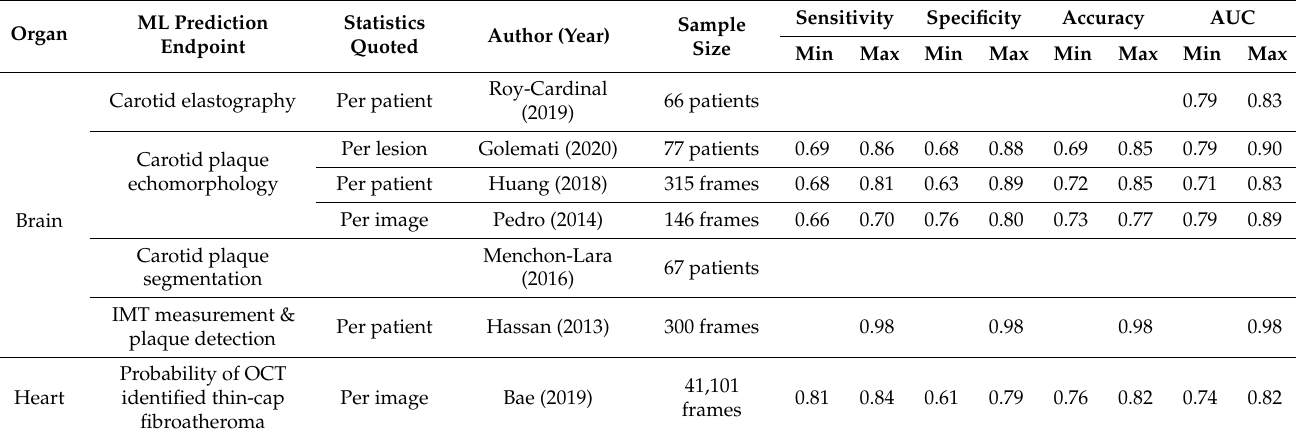
Table 5. Model performance statistics for ML quantitation using B-mode US and